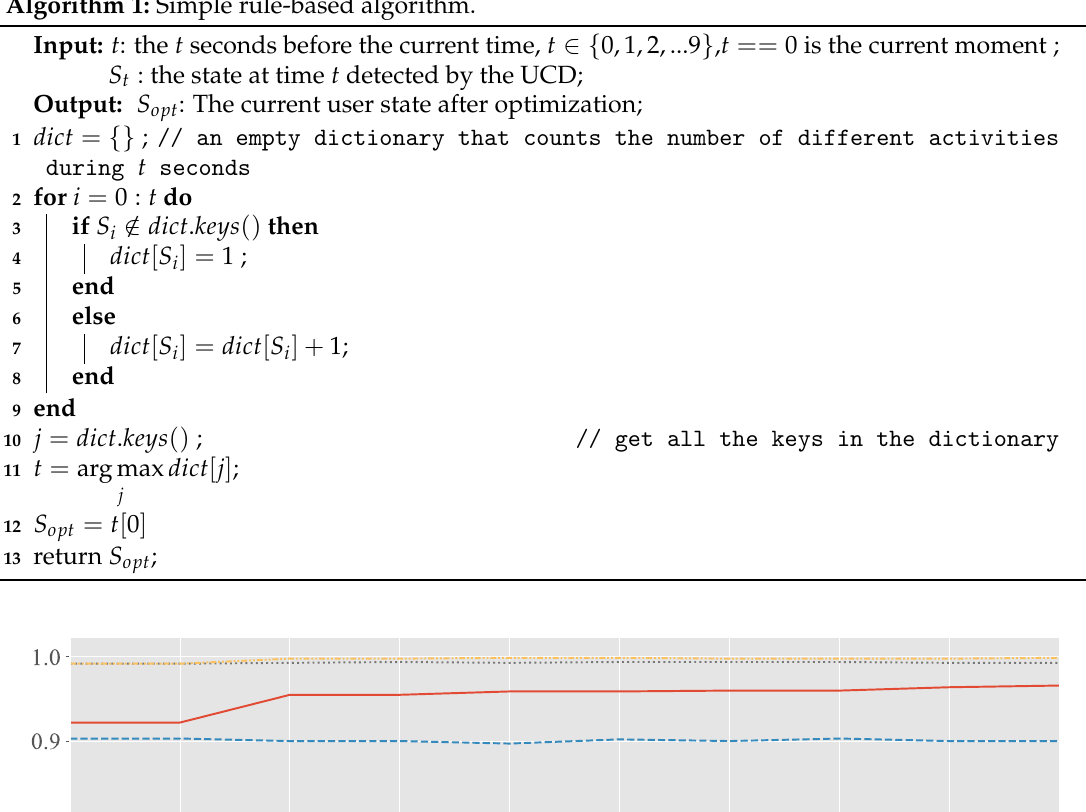
Algorithm 1: Simple rule-based algorithm.